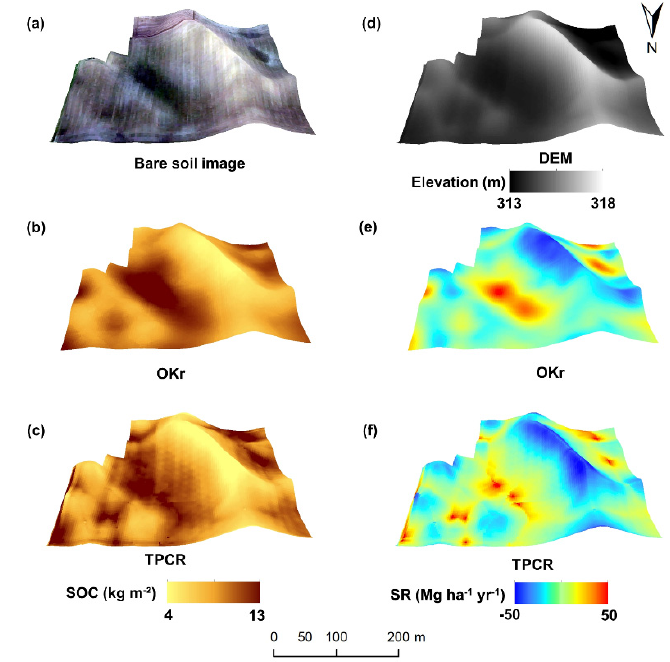
Figure 4. Maps of landscape characteristics and model-derived soil property maps at field site 1: ( a ) bare soil image; ( b ) ordinary kriging (OKr)-derived SOC density; ( c ) TPCR-derived SOC density; ( d ) elevation; ( e ) ordinary kriging (OKr)-derived soil redistribution (SR) rate; and ( f ) TPCR-derived SR rate.